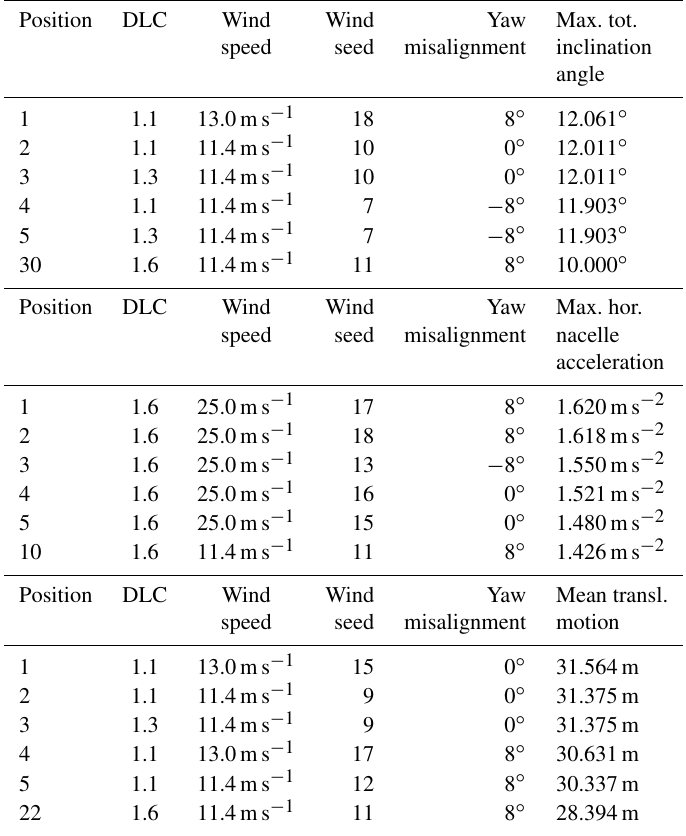
Table 9. The highest values for the three performance parameters and corresponding DLC simulation cases, based on the best-performing floating